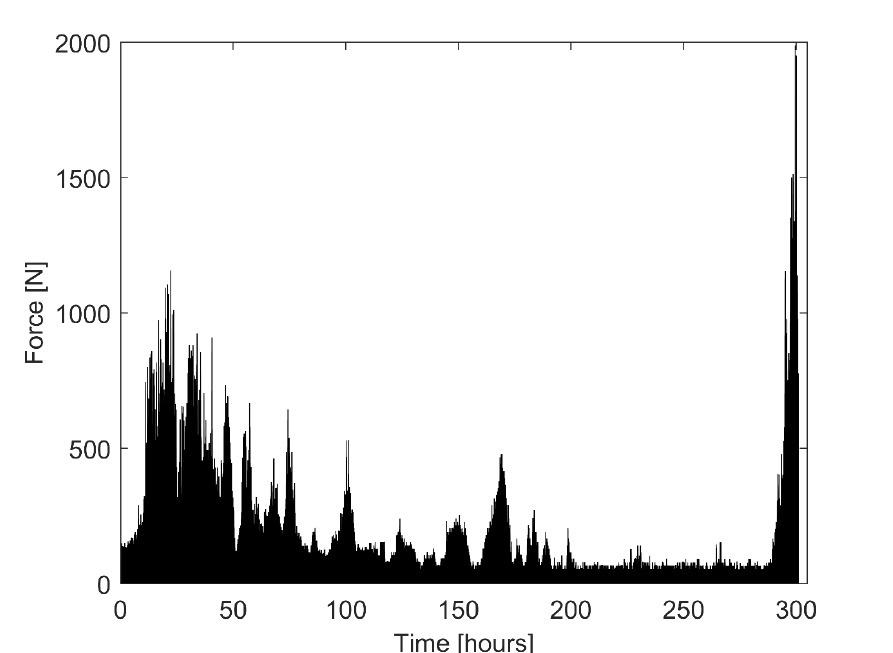
Figure 5. Force data from the load cell during the whole measurement period.